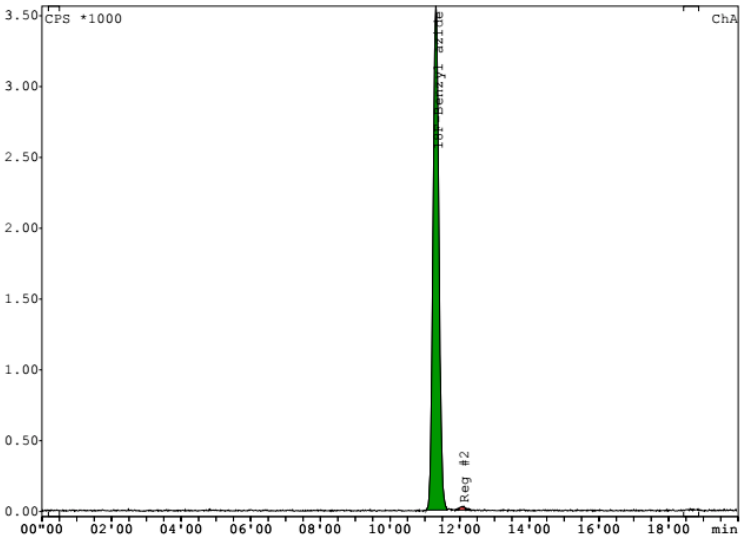
Figure 1. Chromatogram of 4-[ 18 F]fluorobenzylazide after synthesis. Phenomenex Luna18 100 Å (5 µ m, 4.6 × 250 mm) column; mobile phase: 55% acetonitrile and 45% 0.1 M ammonium formate; flow rate 1 mL/min.